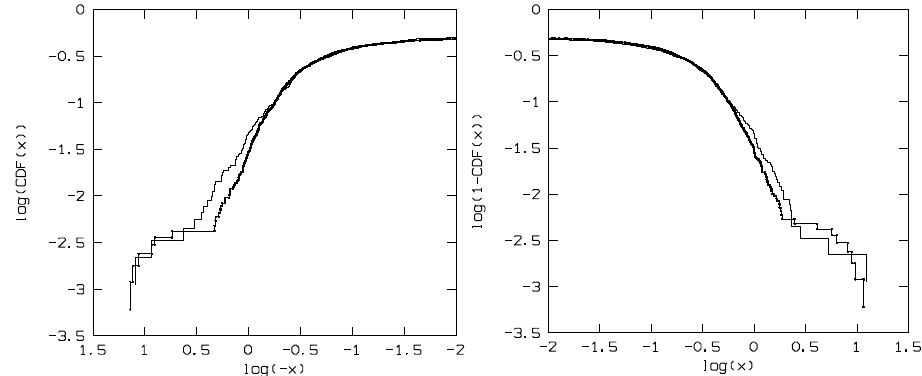
Figure 4. Double logarithmic graphs of CDFs of PKS 2320-035 and CGRaBS J0211+1051. The thin line is the CDF of PKS 2320-035, the thick line is the CDF of CGRaBS J0211+1051. The distributions of PKS 2320-035 and CGRaBS J0211+1051 are similar at the 94.9 percent